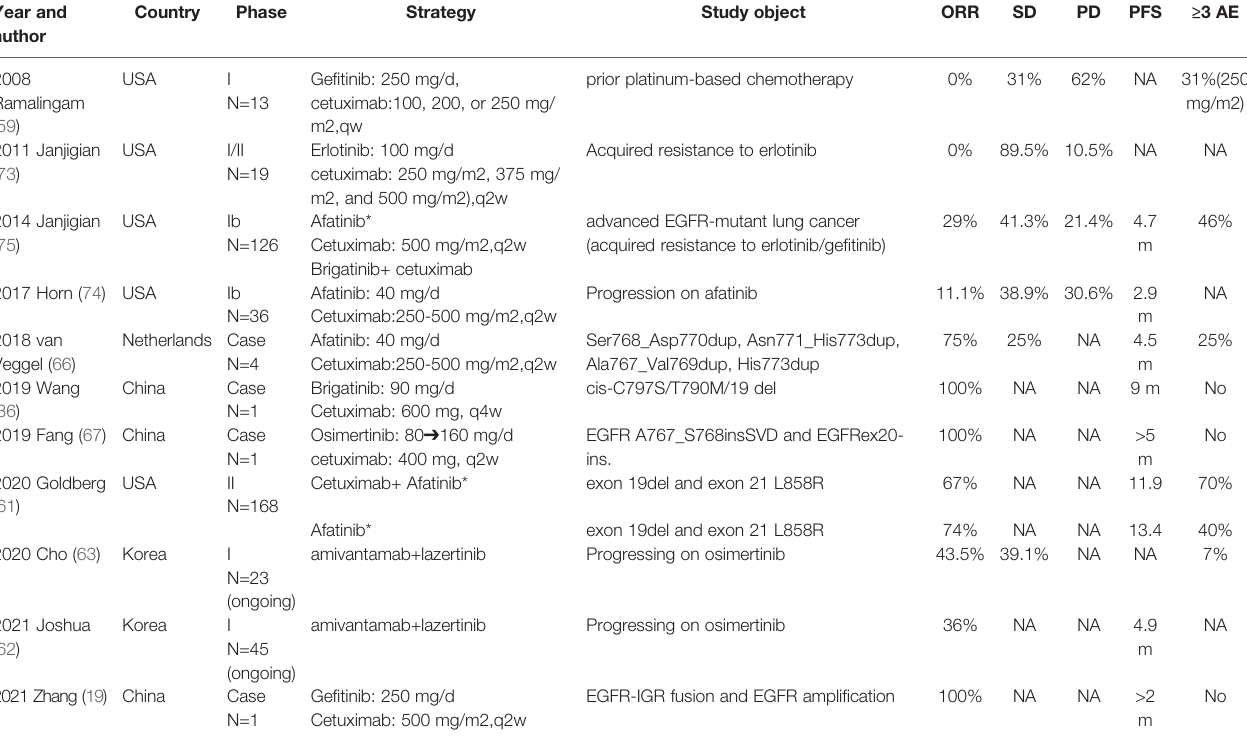
TABLE 2 | Clinical data evaluating the “ sandwich ”